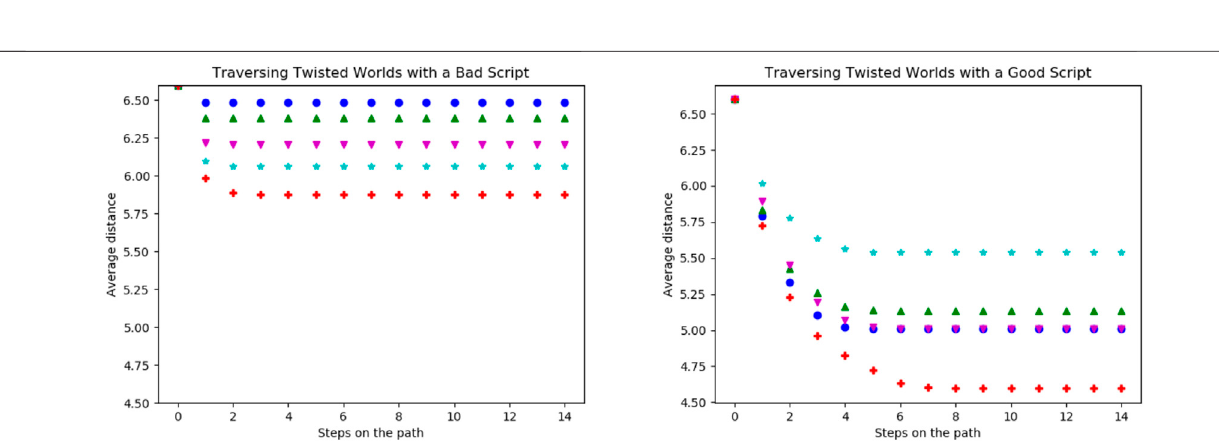
Frontiers in Robotics and AI |